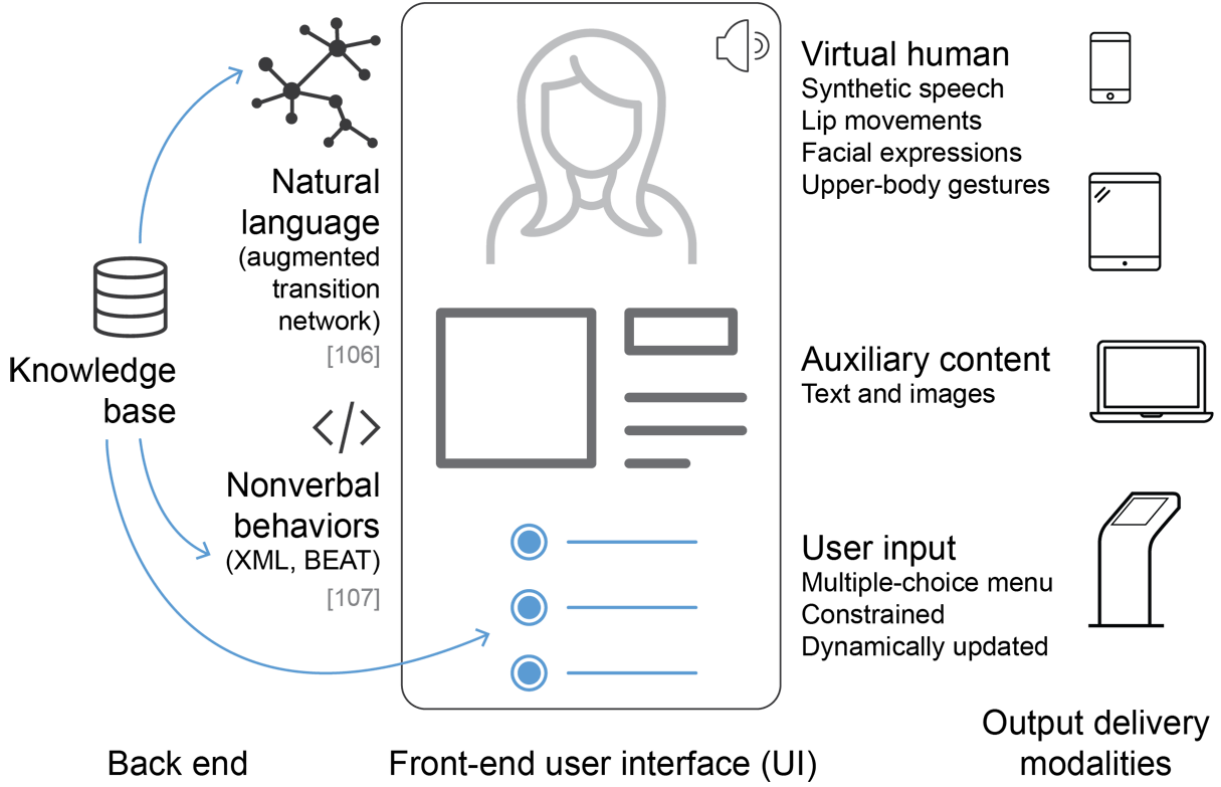
Figure 2. The most common structure of a simple virtual human system designed for health-related interventions. BEAT: Behavior Expression Animation